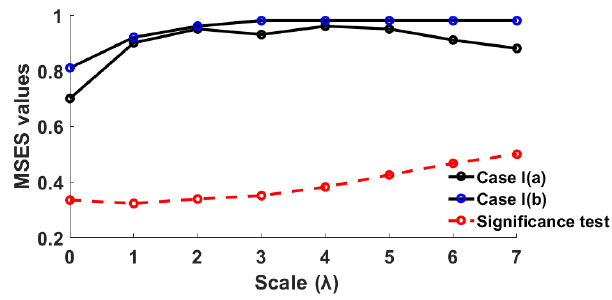
Figure 6. MSES values for case I(a) and case I(b), including sig- nificance test values for the significance level of 1%. The value at scale 0 is equal to the single-scale ES